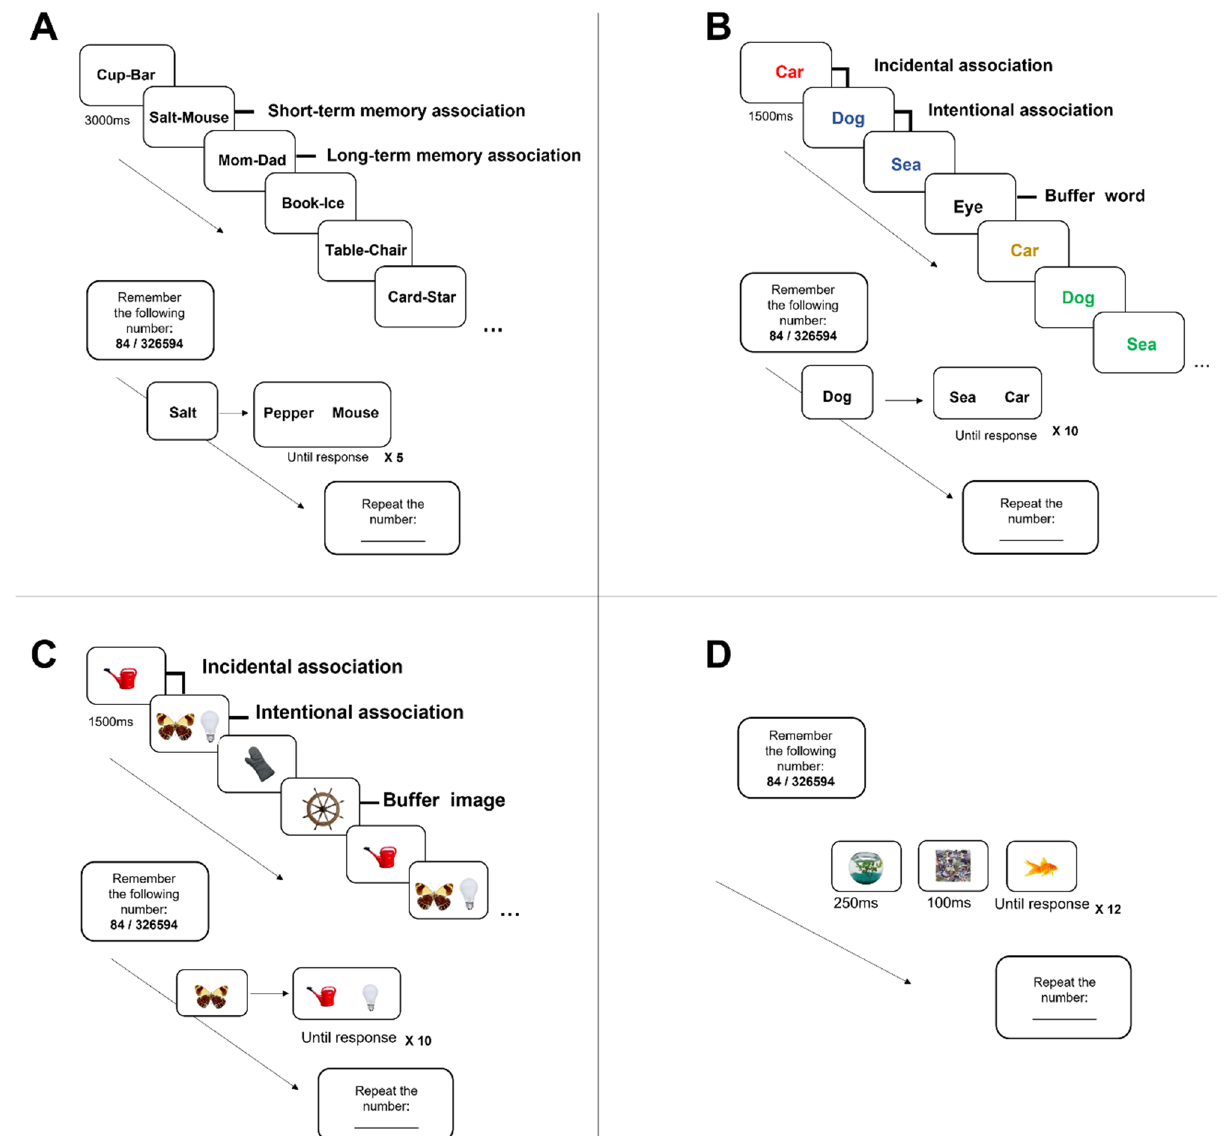
Figure 1. General experiments design. ( A ) Exp. 1. Learning: Participants were asked to associate words that appear together, which either formed a novel association or a LTM association. Every word pair was presented twice for 3000 ms. Test: Participants indicated which of two possibilities was the target associated with the cue. The distractor was either associated with the cue in LTM, or an unrelated buffer word. ( B ) Exp. 2. Learning: Participants were asked to associate consecutive words that appear in the same color. Every word pair was consistently preceded by the same word, to form an incidental association. Each stimulus was presented four times during learning, for 1500 ms. Test: Participants indicated which of two possibilities was the target associated with the cue. The distractor was either incidentally associated with the cue, or an unrelated buffer word. ( C ) Exp. 3. Learning: Participants were asked to associate images that appeared in pairs for a following memory test. Every image pair was consistently preceded by the same image, to form an incidental association. Each stimulus was presented four times during learning, for 1500 ms. Test: Participants indicated which of two possibilities was the target associated with the cue. The distractor was either the image incidentally associated with the cue, or an unrelated buffer image. ( D ) Exp. 4. Participants were asked to determine whether a target image appearing on screen is real or meaningless. In each trial, a prime appeared for 250 ms, followed by a 100 ms presentation of a mask. Following masking the image to be judged as object/non-object appeared for the maximum of 5 s or until response. In all experiments, test trials were run under high/low cognitive load condition. Participants were asked to remember 2 digits or 6 digits in the low and high load groups respectively. Presentation of the digit-string to remember, was followed by test trials of the main task, after which participants reported the digit-string they memorized. All images taken from Brady et al. 44